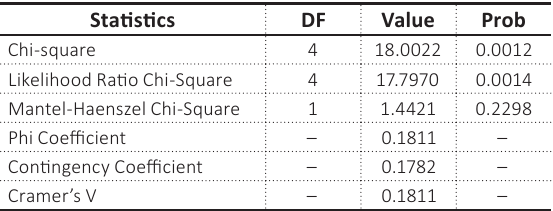
Table 4. Dependence between the quality rating